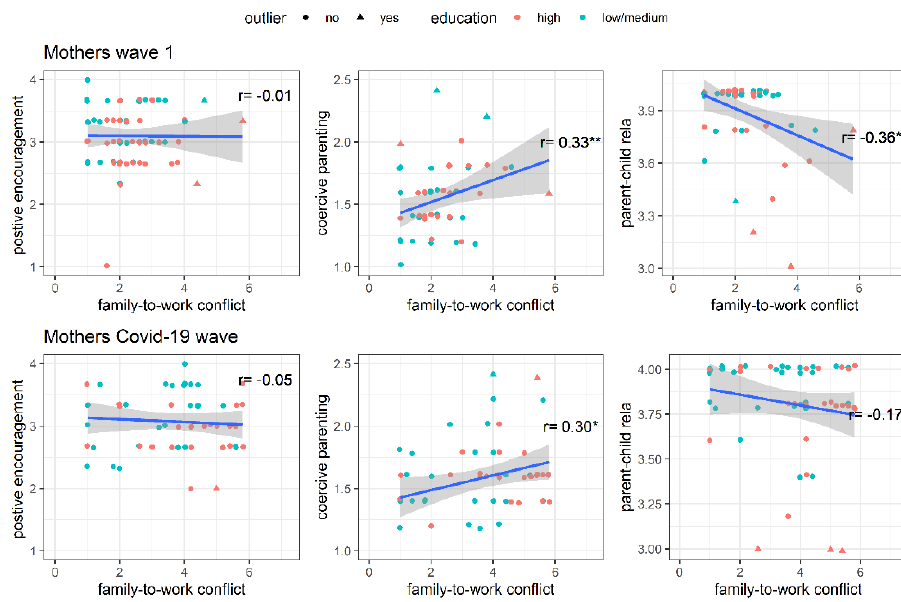
Figure A.1 F → W-conflict and perceived parenting for mothers